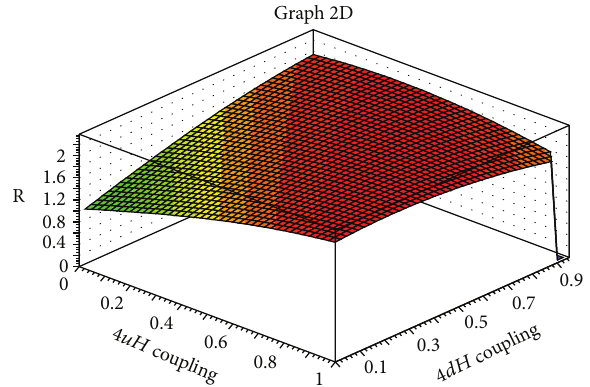
Figure 9: The surface in the space of parameters of the suppression factors 4𝑑𝐻 , 4𝑢𝐻 , and 4𝑙𝐻 in the Higgs coupling to the quarks and leptons of the 4th generation, at which the median value of ratio 𝑅 = 1.1 , measured in the CMS experiment at LHC [40], is reproduced.